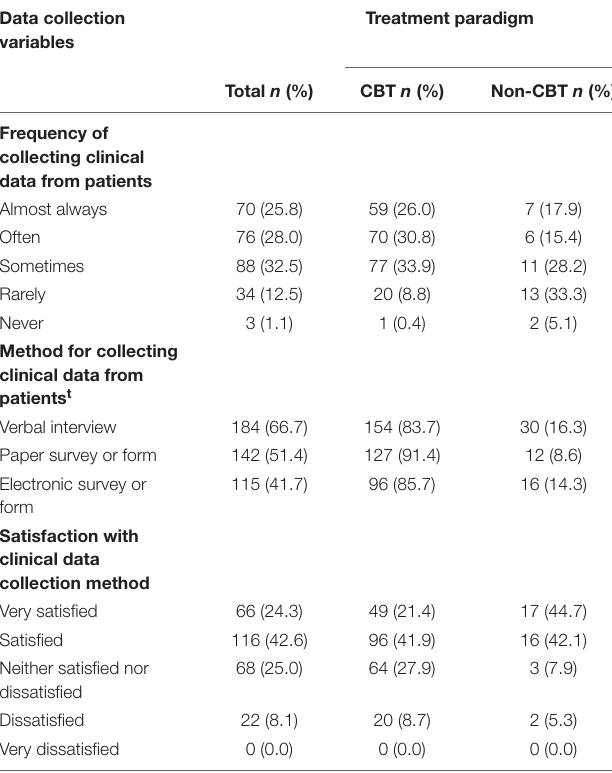
TABLE 5 | Collecting clinical data from telemedicine